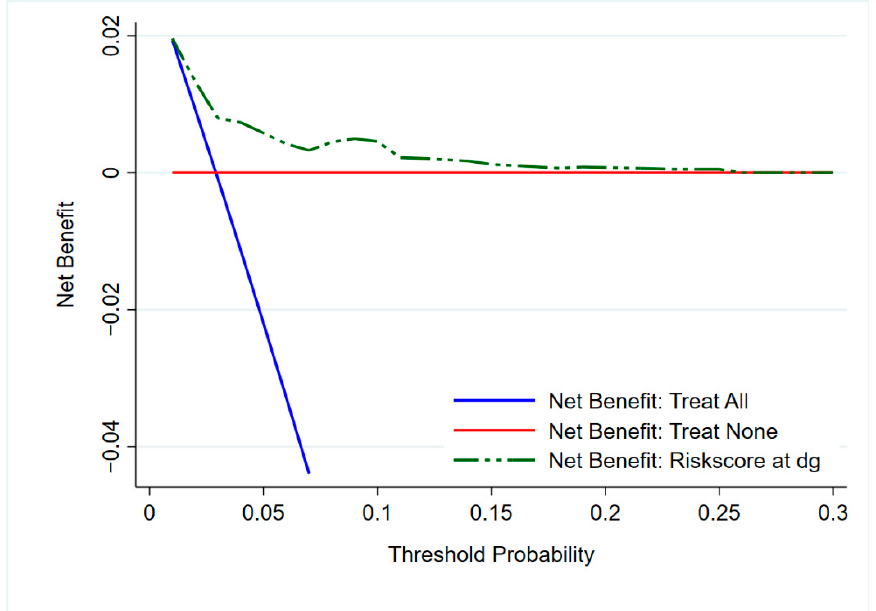
Figure 4. Decision curve analysis for the simplified risk score at diagnosis. The dotted green line is